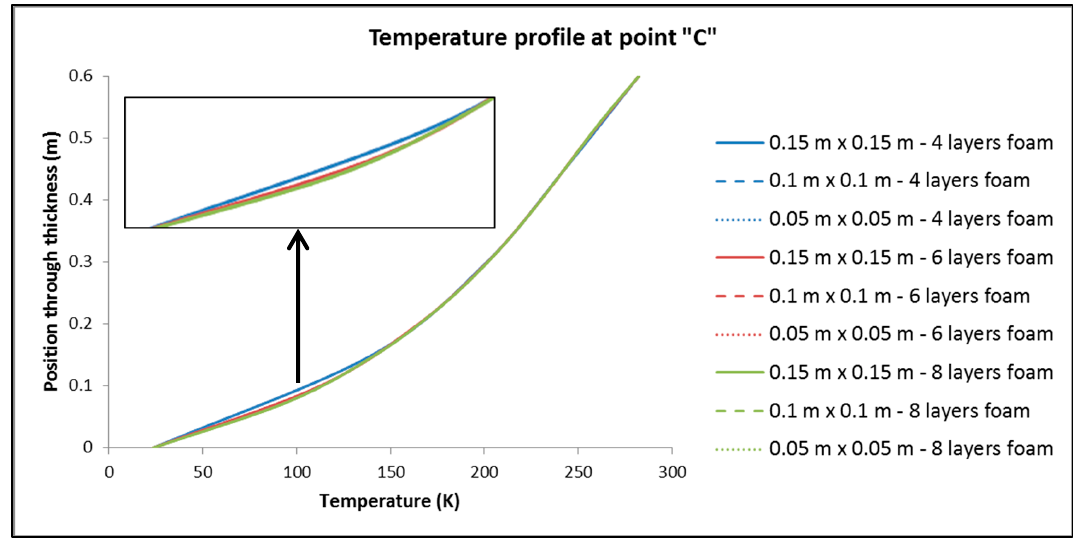
Figure 8. Temperature profile through the insulation thickness at point “C” of Figure 5.